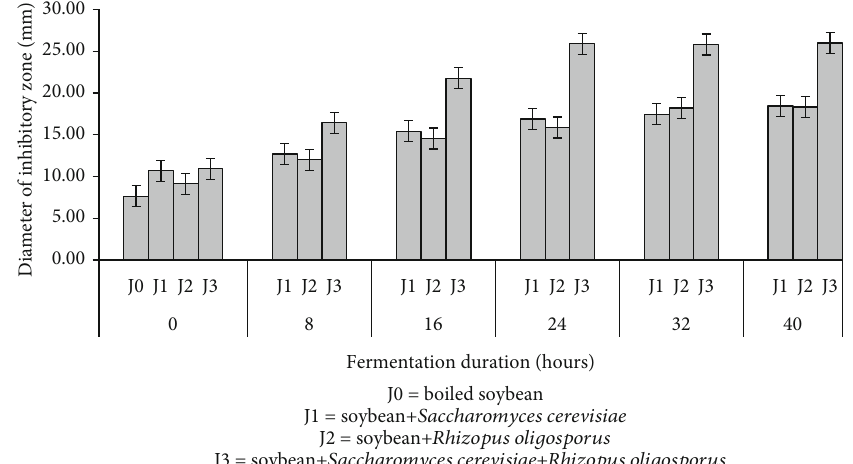
Figure 4: Antibacterial activities of soybeans inoculated by a culture of Saccharomyces cerevisiae , a culture of Rhizopus oligosporus , and a mixed culture of both during tempeh